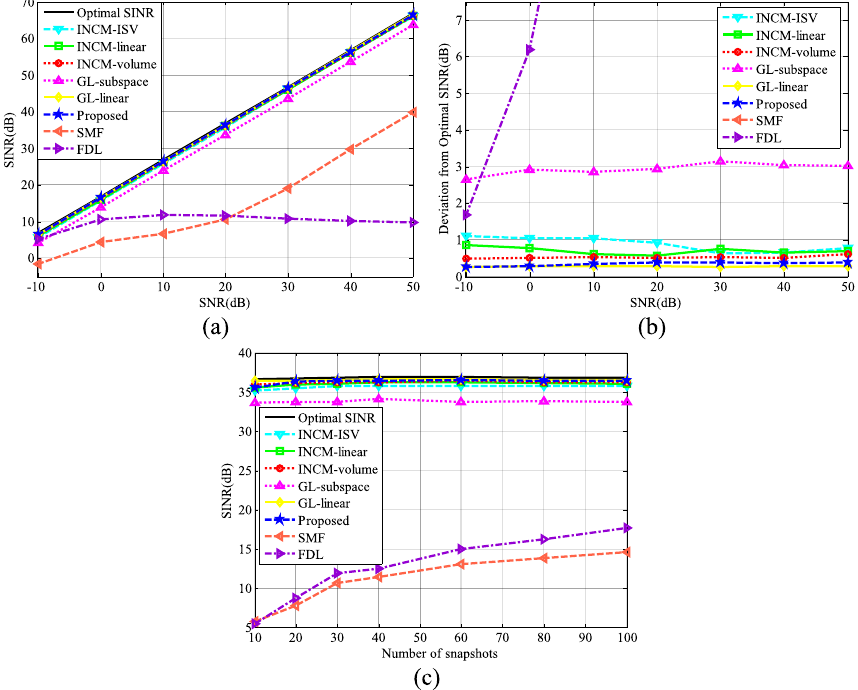
Fig. 7 Performance comparison for the last simulation. a SINR against SNR. b Deviation versus SNR. c SINR against number of snapshots